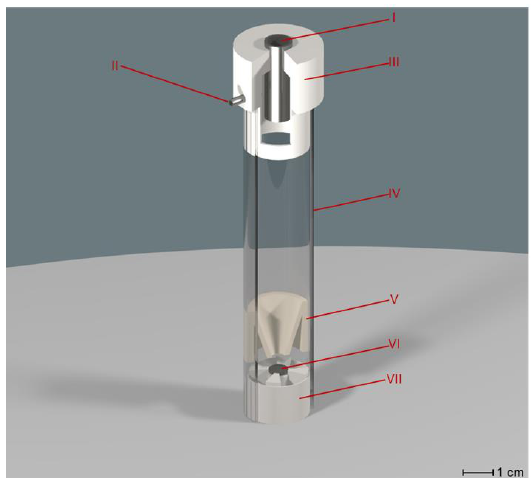
Figure 1. Design and layout of miniaturized atomization device: Part I: inox nozzle holder spare parts; Part II: inlet for drying air; Part III: 3D-printed system (Delrin ® (Polyoxymethylene)) ensuring sealing of the system and cocurrent configuration contact between air and droplets; Part IV: drying chamber; Part V: 3D-printed funnel (Acrylonitrile butadiene styrene (ABS)) for air stream adjustment; Part VI: powder collection in differential scanning calorimetry (DSC) aluminium pan for powder collection; Part VII: perforated 3D-printed DSC pan holder